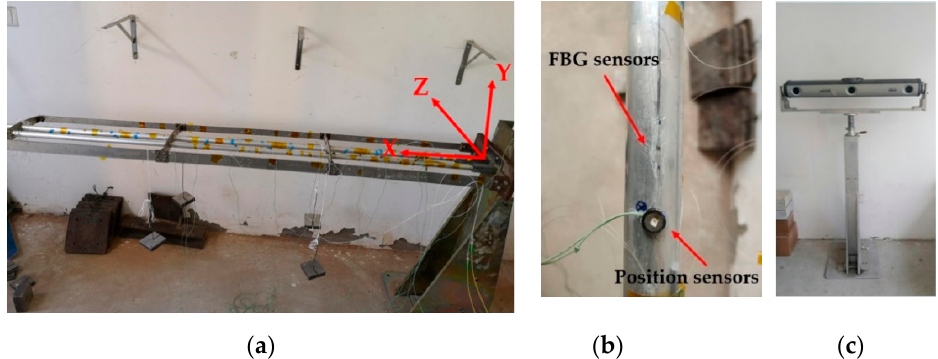
Figure 5. Experimental model of frame: ( a ) Frame model; ( b ) Displacement sensor; and ( c ) Displacement measuring